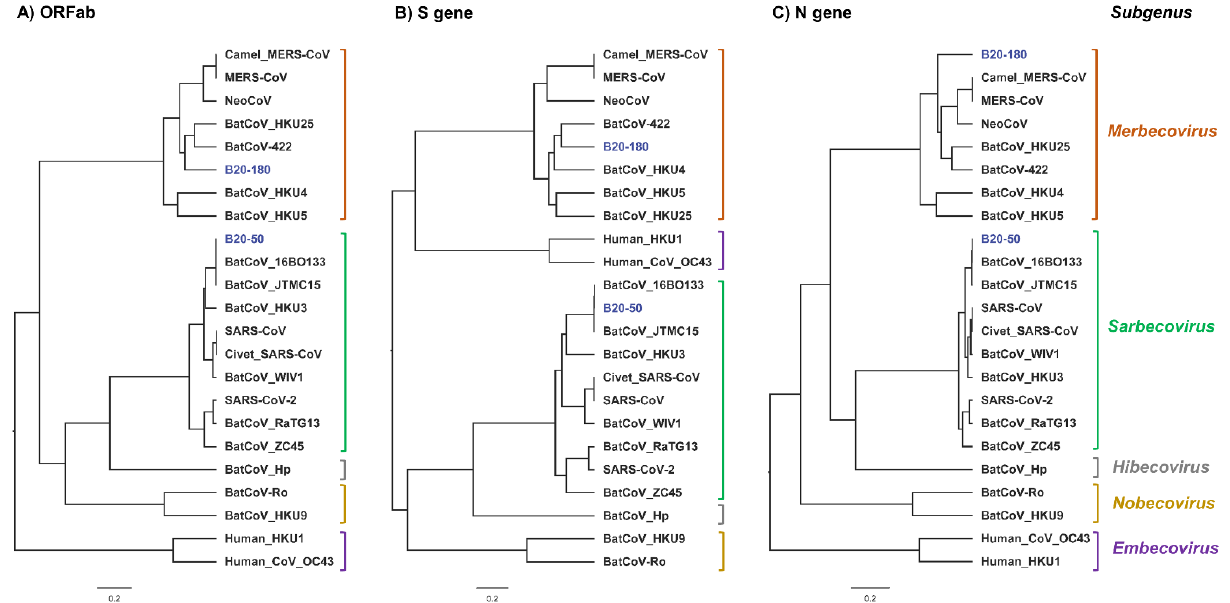
Figure 5. Maximum clade credibility (MCC) tree estimated with dated branches based on the full ORF gene from the complete genome sequences with reference sequence from β CoVs. Sequence names are provided in taxon labels. Strains identified in this study are colored in blue. The ( A – C ) trees are based on ORF1ab, S and N gene, respectively. Statistical support (posterior probability) of all nodes was greater in value than 0.98.